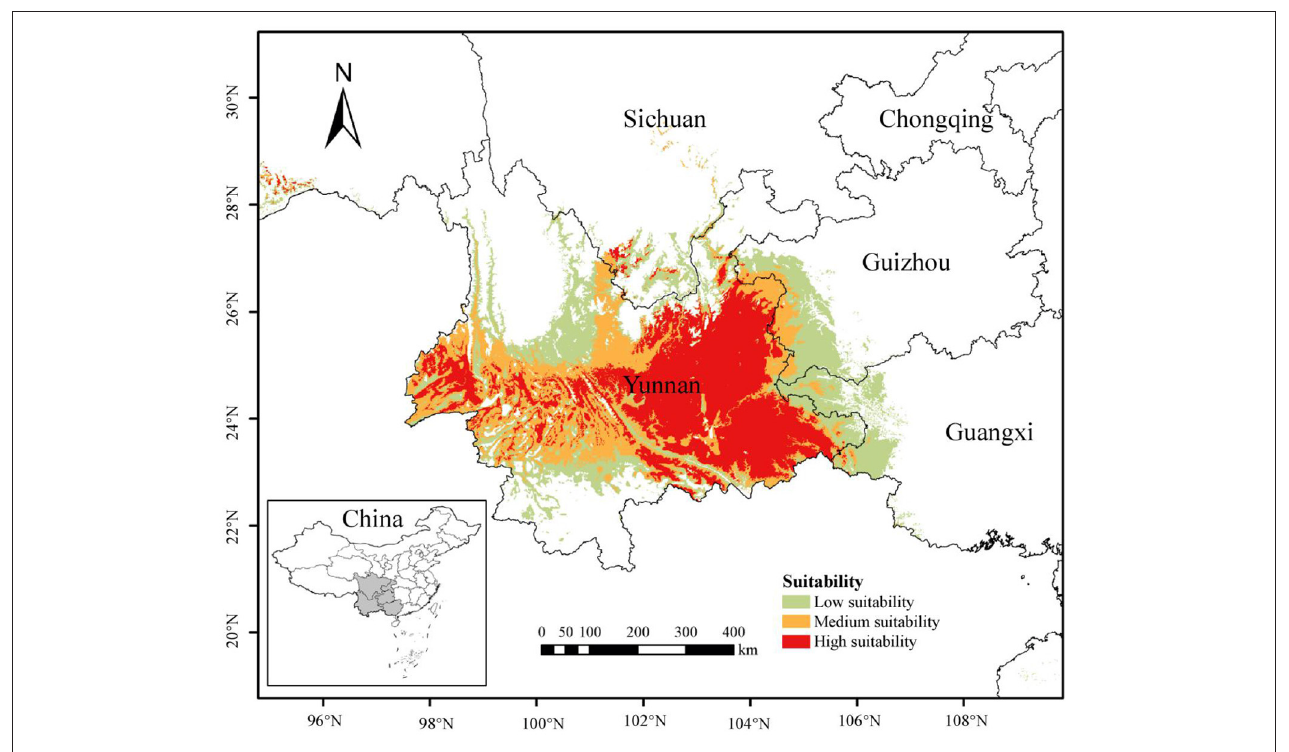
FIGURE 2 | The potential distribution of Panax notoginseng under current climate based on the overall regionalization